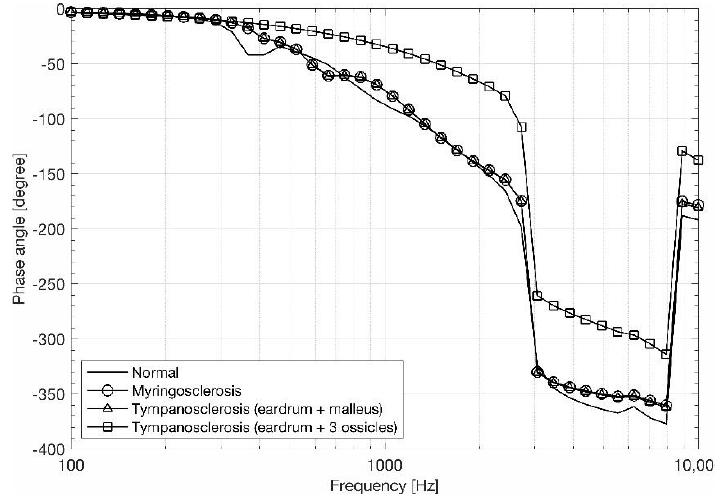
Figure 11. Phase angles for the stapes footplate, comparing different situations.